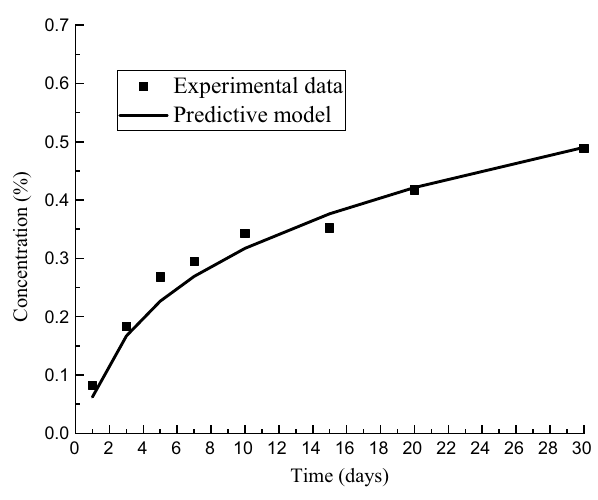
Fig. 8 Comparisons of the data from experiments and analytical model for solution 0.5 mol/L and location 5